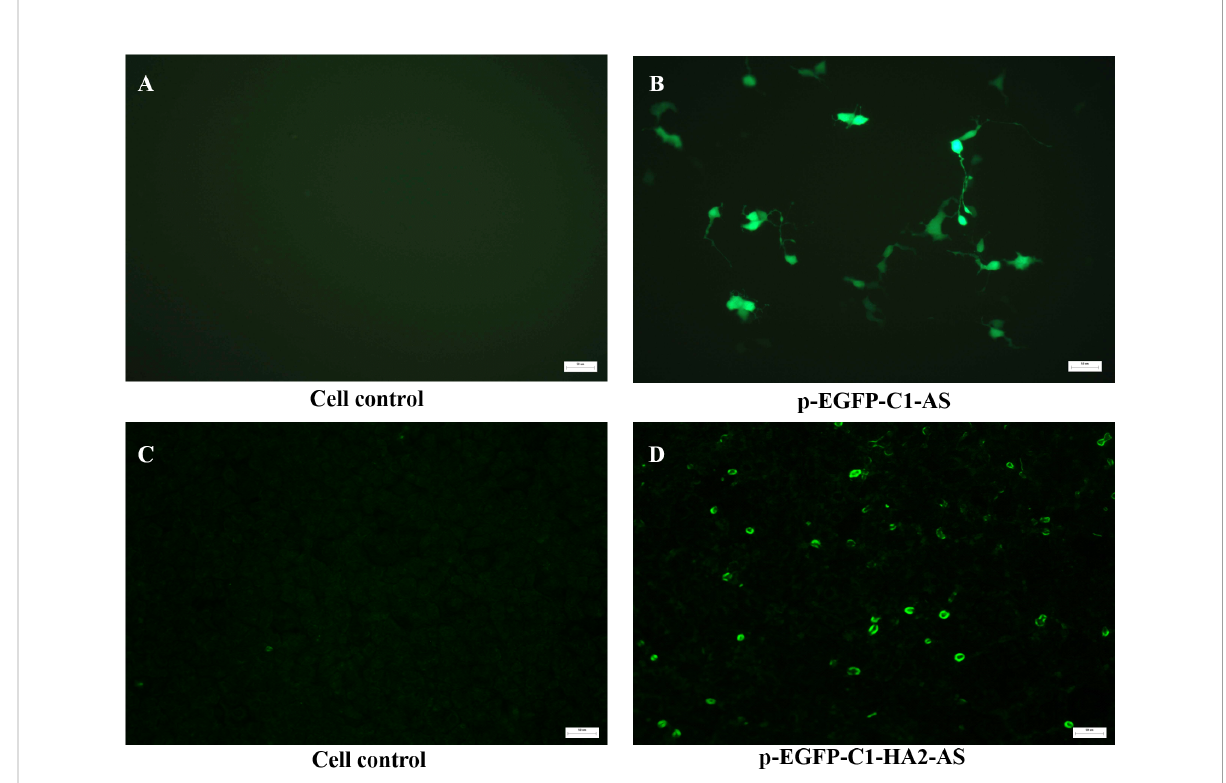
FIGURE 4 In vitro detection of the expression of recombinant plasmid in HEK293T cells transfected with 1 m g pEGFP-C1-AS (B) , pEGFP-C1-HA2-AS, (D) plasmid by Lipofectin, and untreated cell were controls (A, C) . The expression of EGFP by pEGFP-C1-AS was directly detected using fl uorescence microscopy, while HA2 protein expressed by pEGFP-C1-HA2-AS was detected by anti-AIV H5 polyclonal primary antibody and FITC-conjugated goat anti-chicken secondary antibodies using an immuno fl uorescence